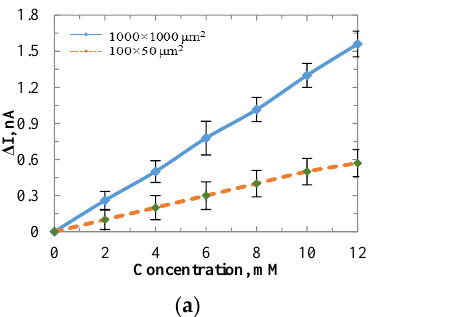
Figure 6. ( a ) Definition for current overshoot (I’), current fluctuation ( ∆ I), and transition time (T o ). ( b ) Responsive current values at different time points after adding the lactate solution.